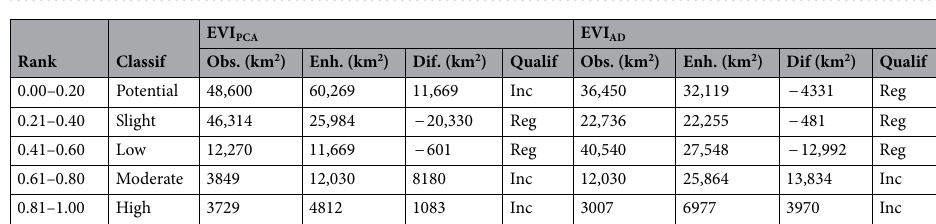
Table 8. Observed and enhanced vulnerability areas. Note Classif. = classification, Dif. = difference, Qualif. = qualification, Inc. = increase and Reg. =